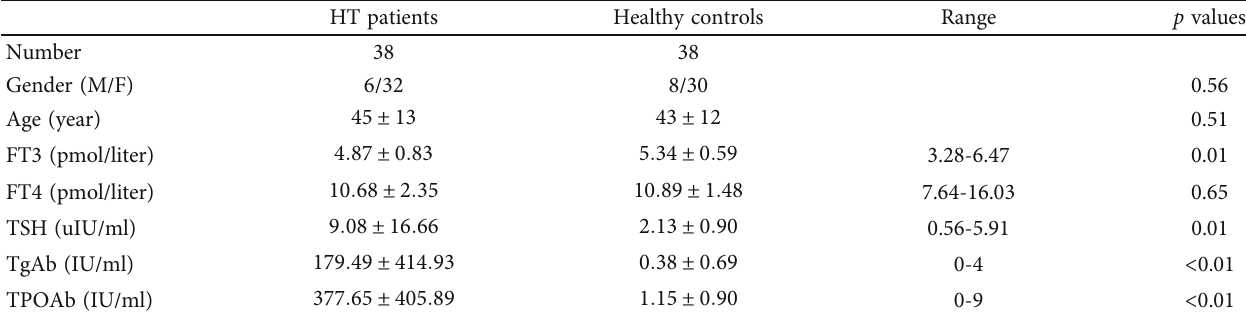
Table 1: Clinical features of HT patients and healthy controls induced in the study.